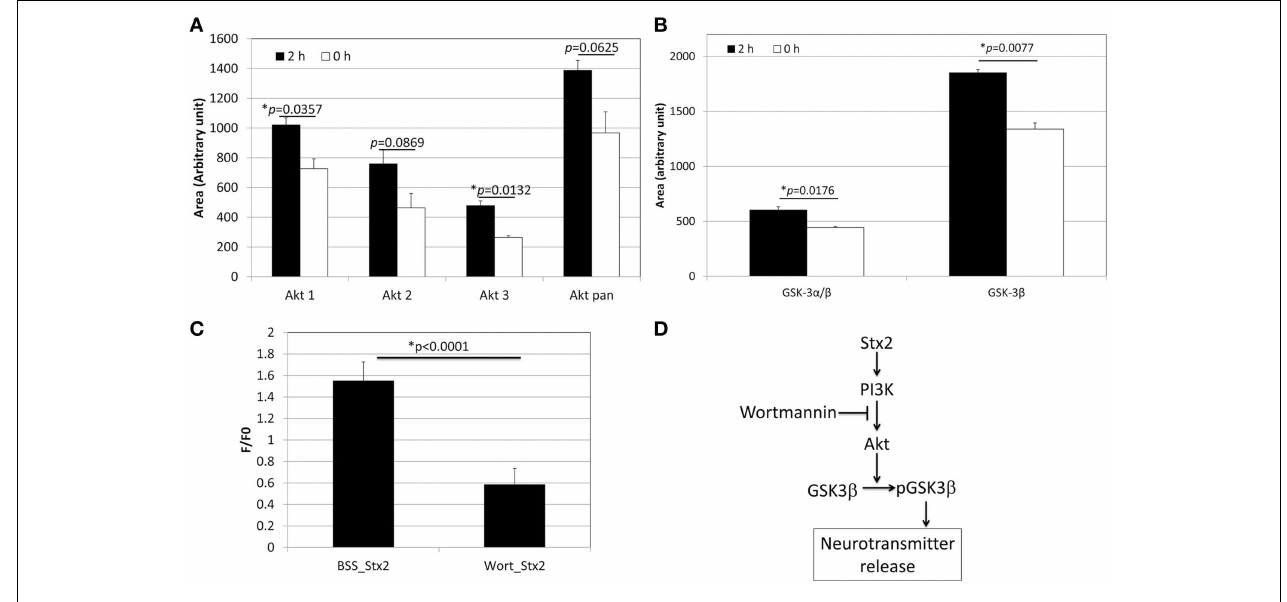
Neurons were incubated with a PI3K inhibitor Wortmannin (Wort) and analyzed by Ca 2 + imaging. Wortmannin significantly decreased Stx2-induced intracellular Ca 2 + (BSS n = 7 and Wort n = 4 , Student’s t -test). (D) A schematic presentation of the proposed Stx2-induced